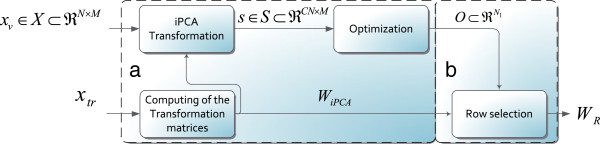
Blocks for computing the reduced iPCA Transformation Matrix. (a) search of the reduced dimension vector O(b) building of the reduced iPCA transformation matrix WR. Note that this process is conducted during a configuration stage, before the classification.